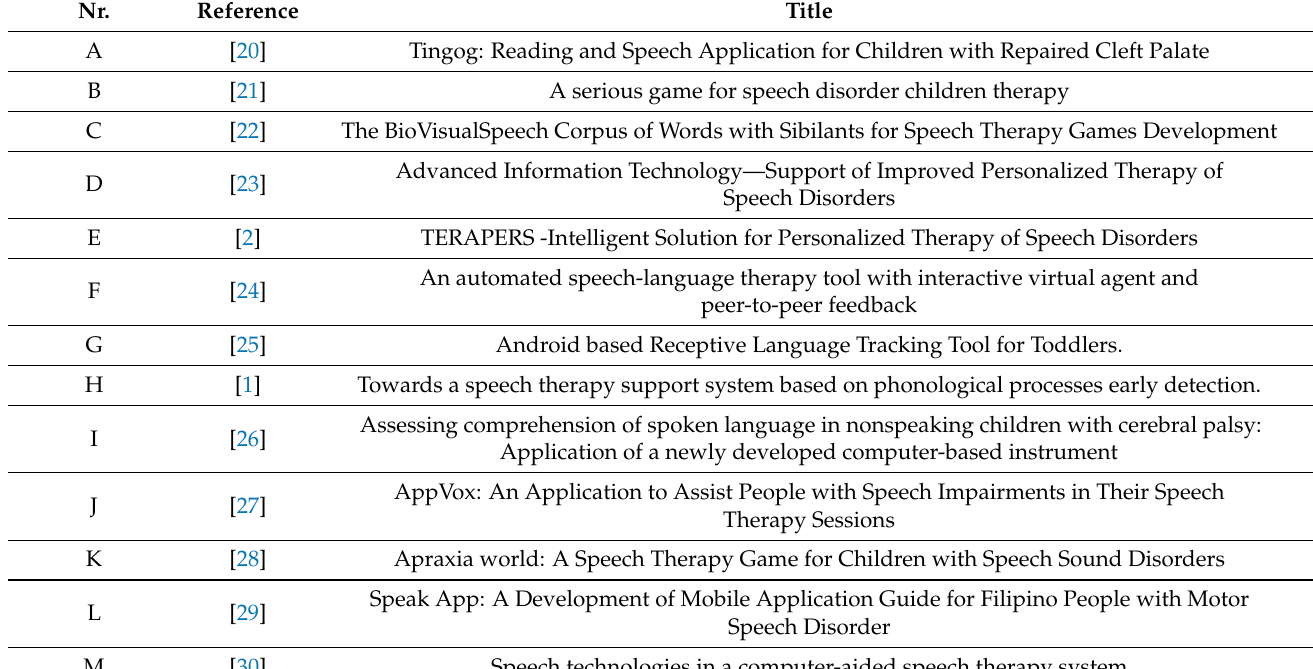
Table 4. Final articles